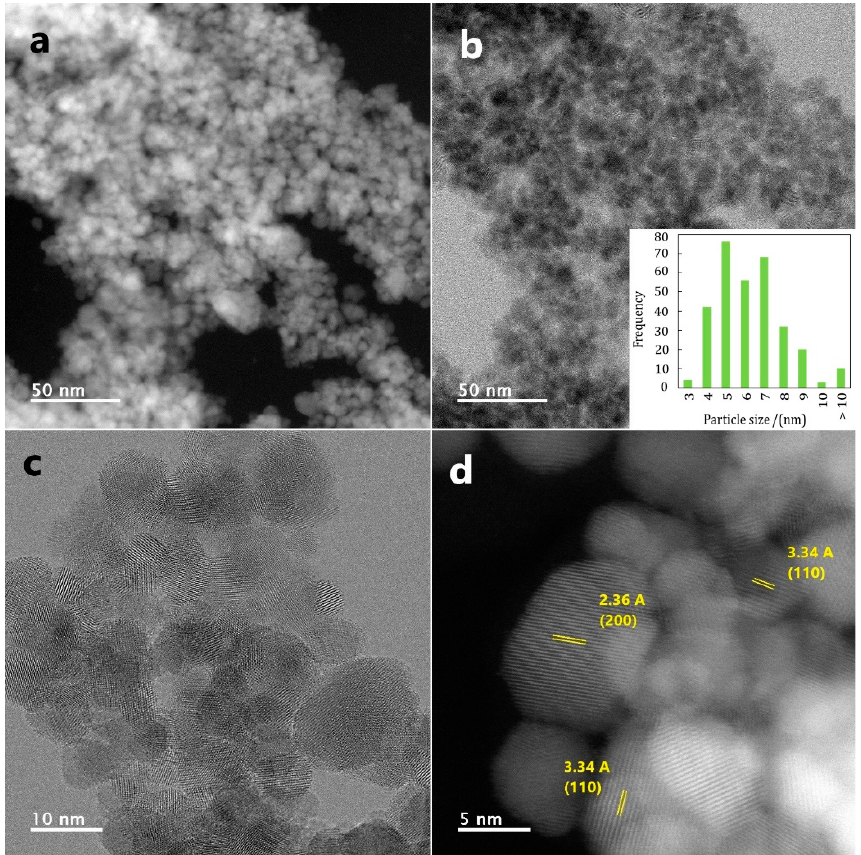
Figure 2. TEM images of ATO ( a ) STEM bright field mode, ( b ) STEM dark field image, in the insert: particle size distribution, ( c , d ) high resolution transmission electron microscopy (HRTEM) images of nanoparticles.